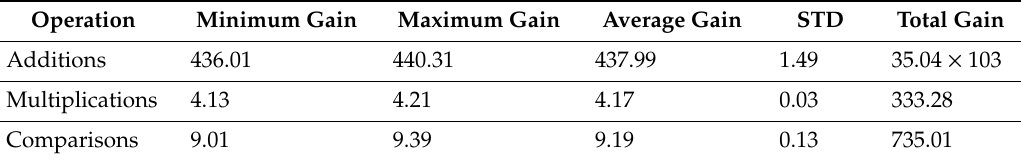
Table 2. The summary of the proposed system computational